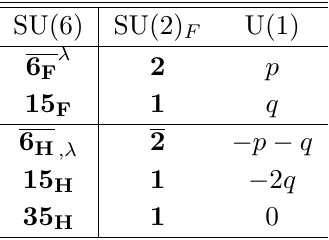
Table 5 . The SU(6) fermions and Higgs representations under the global DRS symmetries in eq.